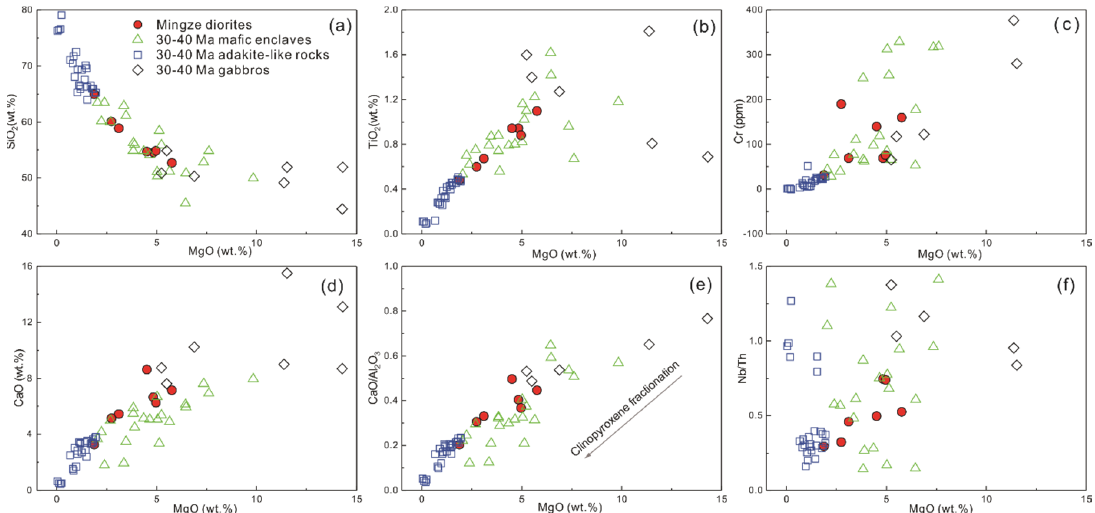
Figure 9. Representative major, trace elements plots of Mingze monzodiorites. ( a ) MgO versus SiO 2 ; ( b ) MgO versus TiO 2 ; ( c ) MgO versus Cr; ( d ) MgO versus CaO; ( e ) MgO versus CaO/Al 2 O 3 ; ( f ) MgO versus Nb/Th ratio.